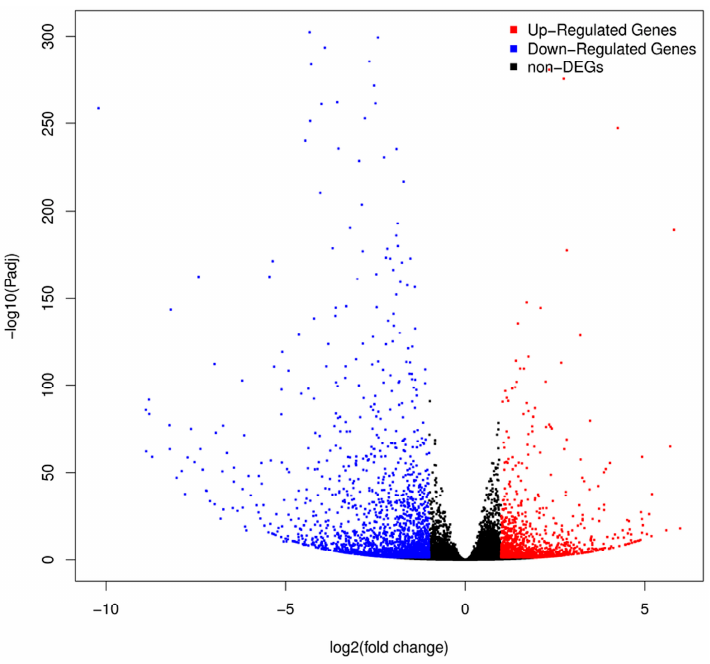
Figure 3. Comparison of gene expression levels between H276A and H276B according to the DEseq2 method.